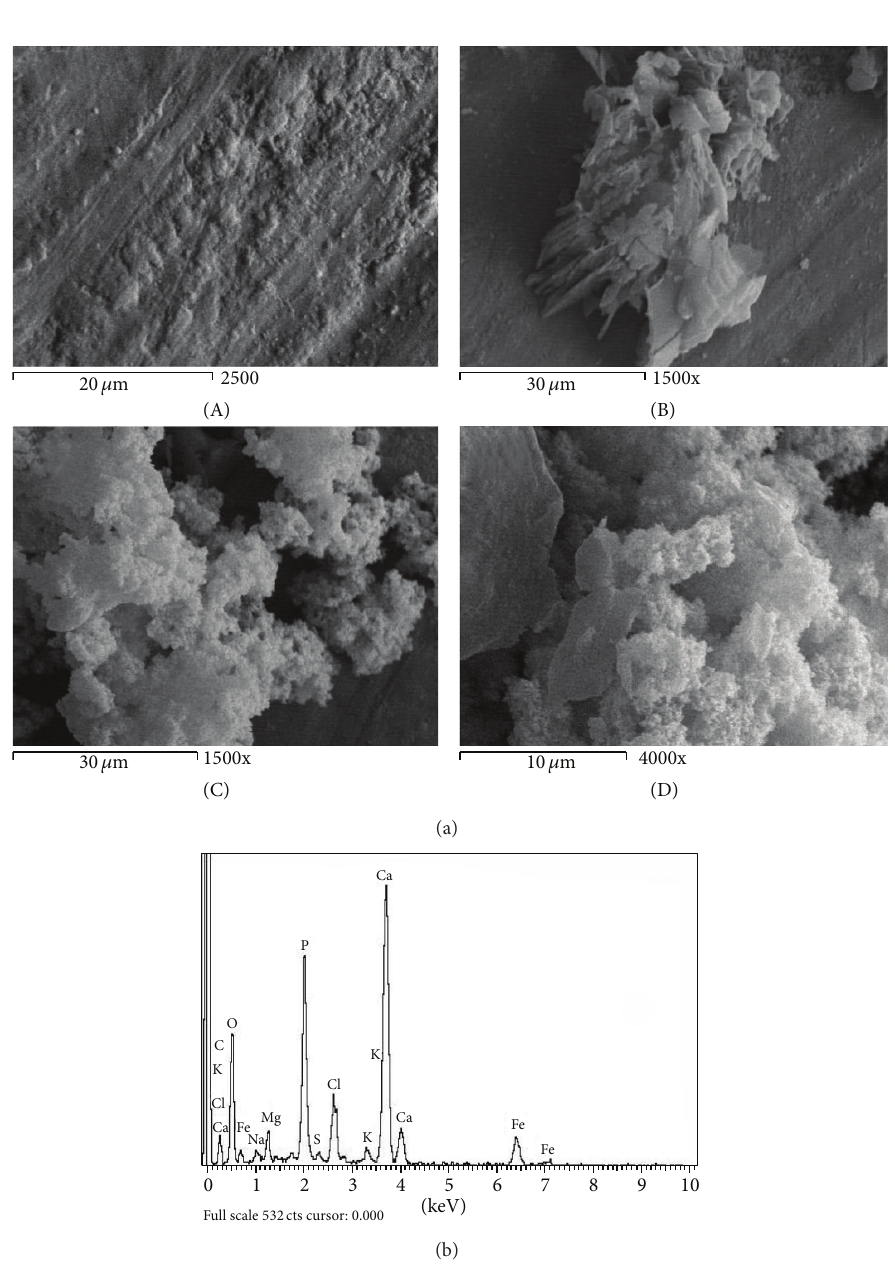
Figure 1: (a) SEM micrograph of Mg-doped glass ceramics (A) before, (B) after 1 week, (C) after 2 weeks, and (D) after 4-week immersion in SBF. (b) EDAX of Mg-doped glass ceramics after 4-week immersion in